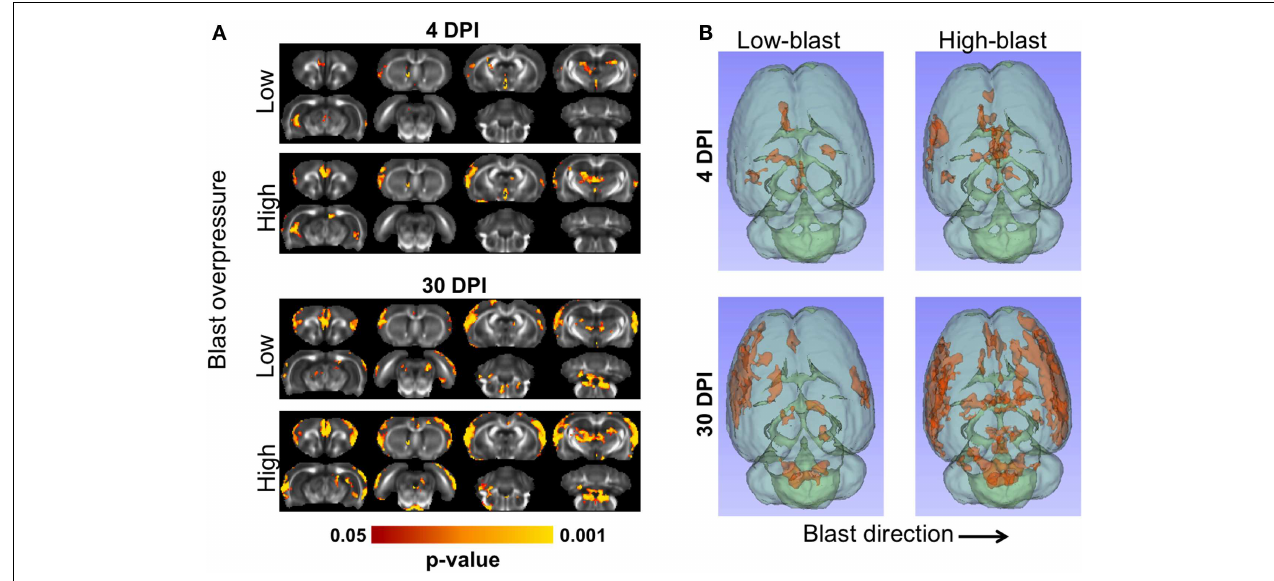
there were more significant voxels at 30days post-blast in both blast exposures. Decreased FA was most prominent in the cortex, but also included the thalamus, and ipsilateral ventral hippocampus.The three-dimensional distribution of significant changes compared to sham are shown (B) as viewed from the top of the brain.The direction of blast is indicated by the arrow and is identical for both